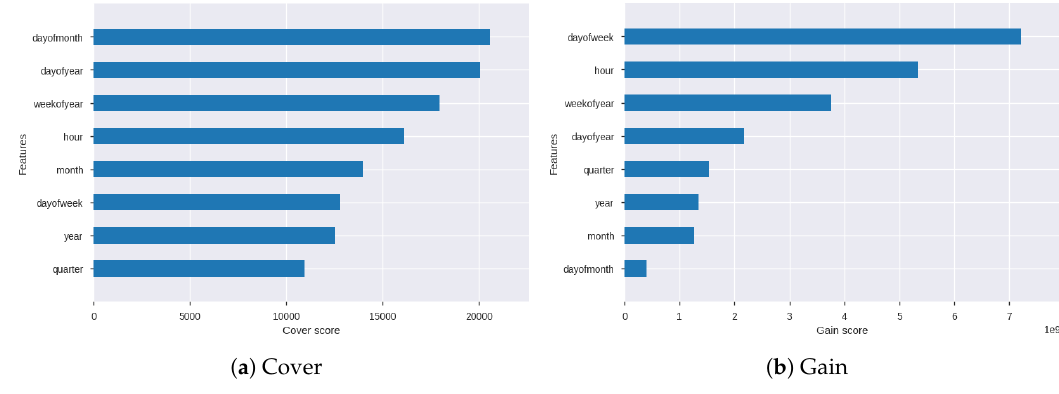
Figure 13. Feature importance score of gain and cover.